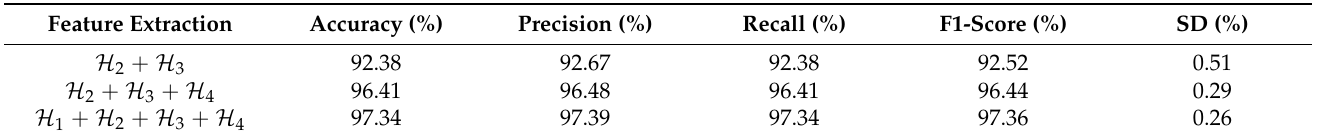
Table 8. Performance comparison via an ablation test of different feature combinations in signed-letter recognition (letters A–Z).